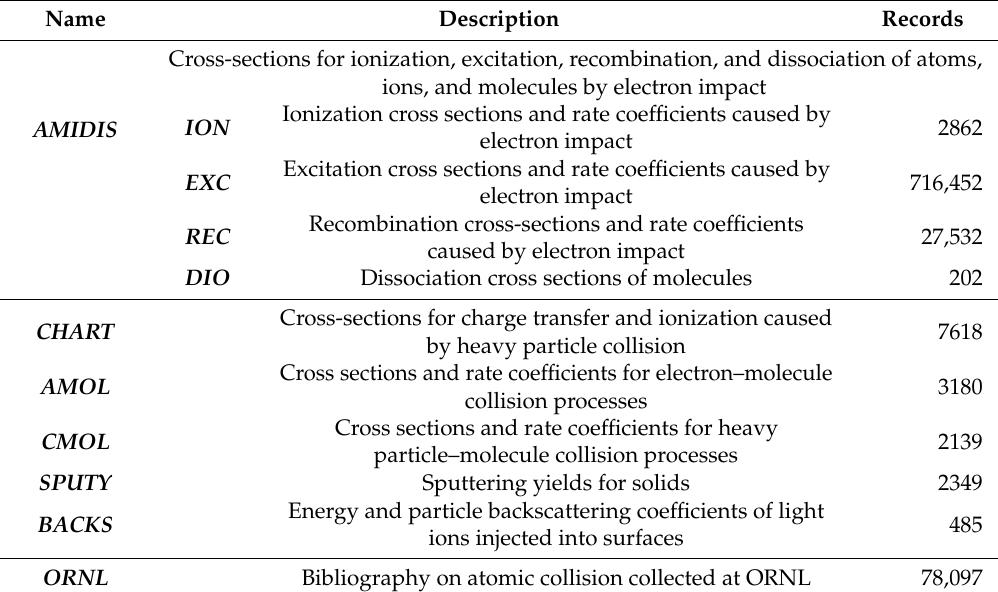
Table 1. Contents of the NIFS Atom and Molecular Database (NIFS DB) as of June 2019. The NIFS DB stores numerical and bibliographic